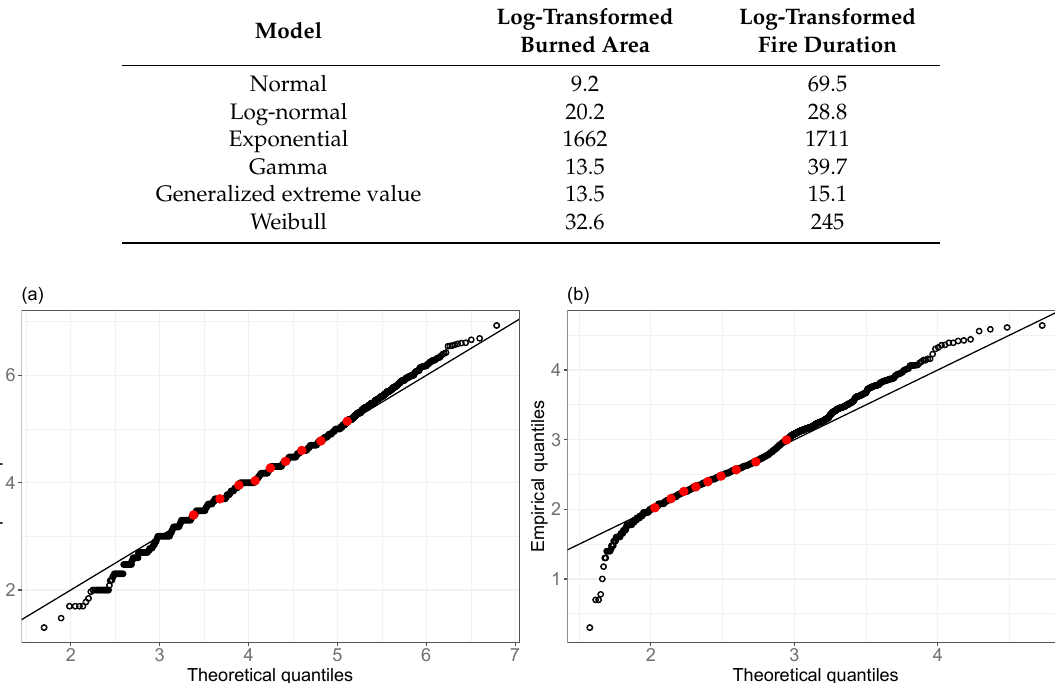
Figure 9. Q-Q plots of the normal distribution of log-transformed burned area ( a ) and of the generalized extreme value distribution of log-transformed fire duration ( b ). Red circles highlight the deciles of the distributions.